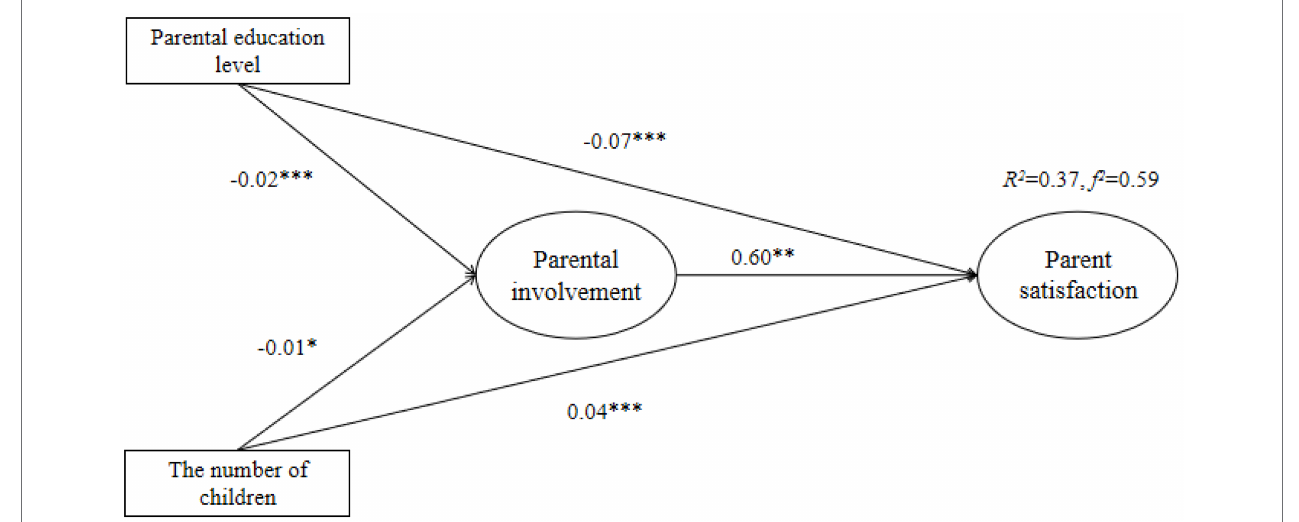
FIGURE 2 | The verification of the research model. *** p < 0.001; ** p < 0.01; and * p <